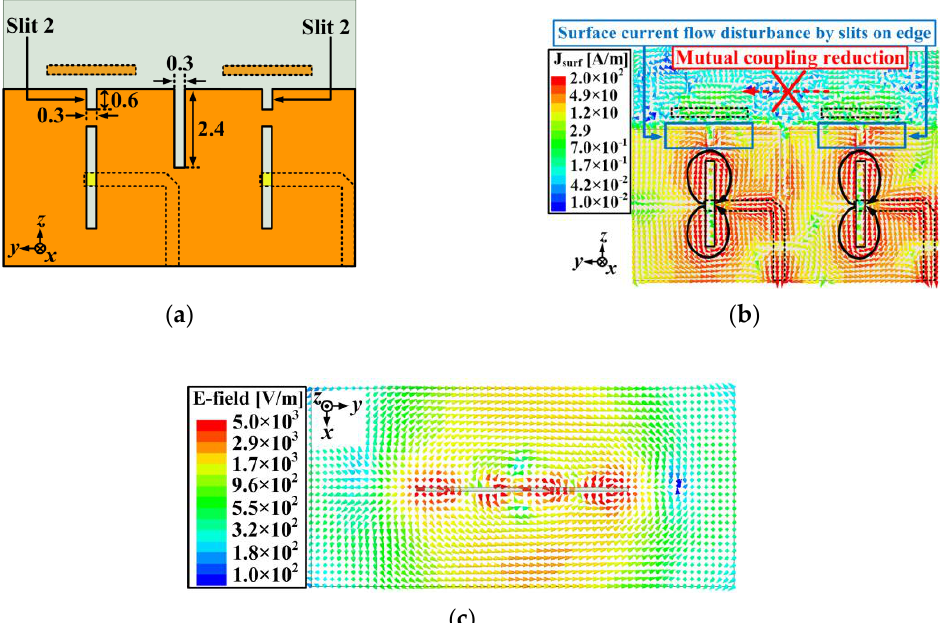
Figure 11. The 1 × 2 array antenna with Slit 1 and Slit 2: ( a ) top view, ( b ) simulated surface current distribution at 28 GHz, and ( c ) simulated E-field distribution in the E-plane at 28 GHz.